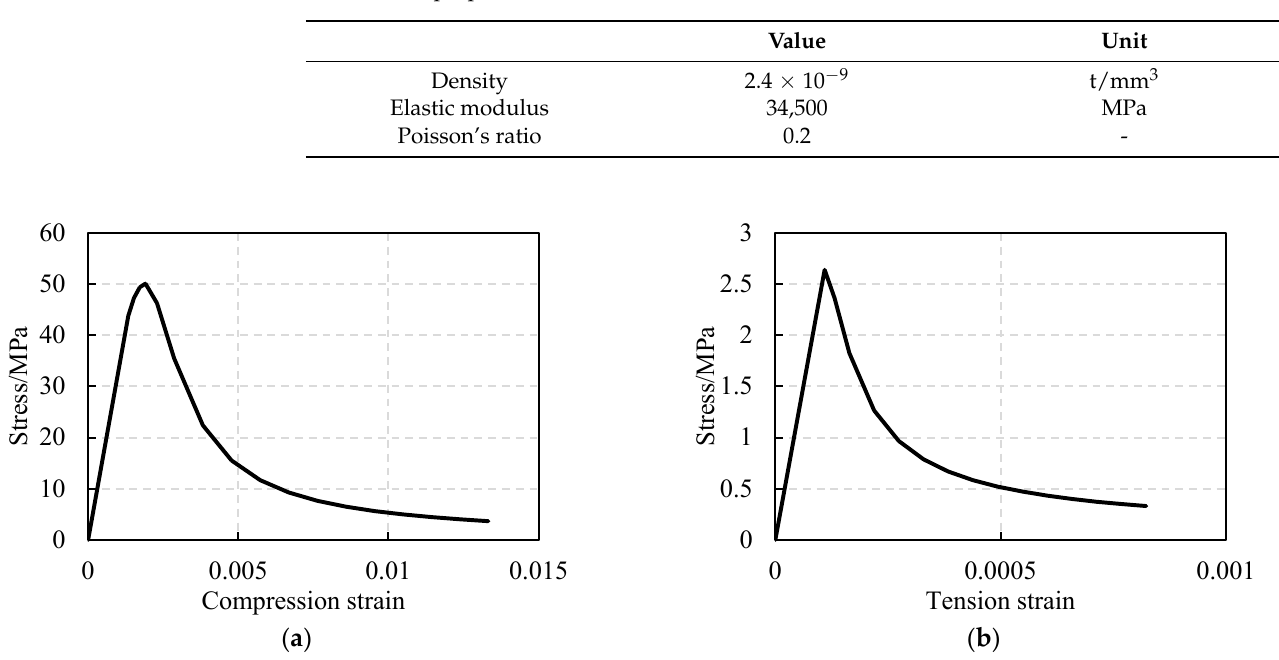
Table 7. The properties of concrete in the numerical model.